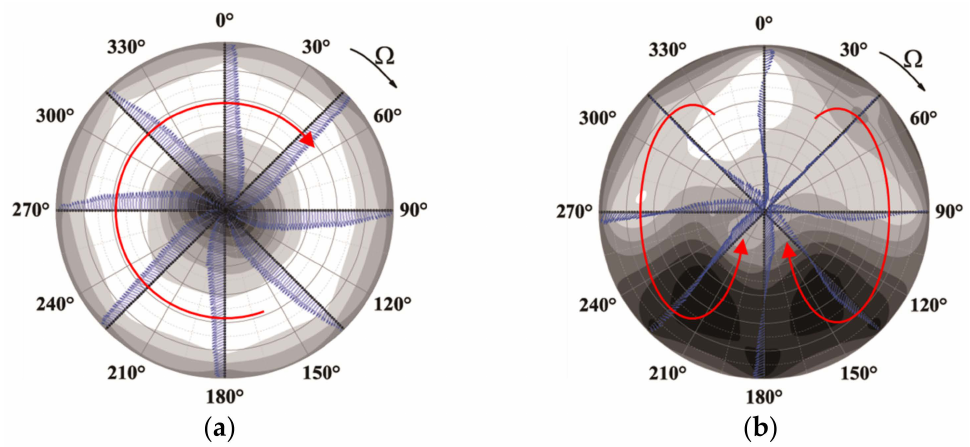
Figure 4. Inlet total pressure and velocity profile Vyz under the conditions of ( a ) +10 (co-rotating bulk swirl distortion) and ( b ) +10 − 10 (twin swirl distortion).